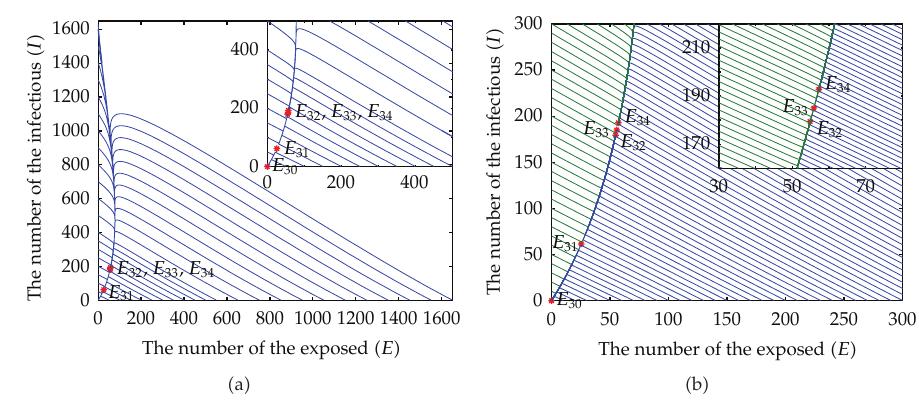
Figure 6: Phase portrait of model (cid:2) 3.10 (cid:3) : a case of multiple equilibria.